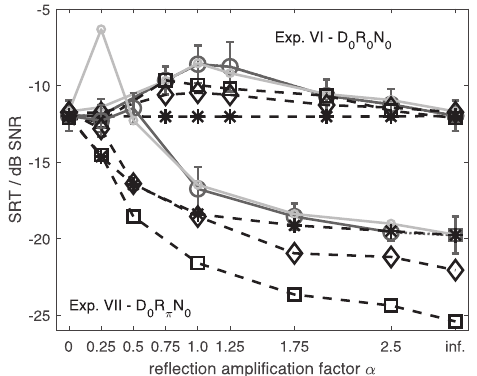
Figure 4. Measured and predicted SRTs for experiments VI and VII in the same display as in Figure 3. This fi gure shows the in fl uence of a single re fl ection of the target speech with a delay time of 200 ms, which was varied in its amplitude from 0 to 2.5.